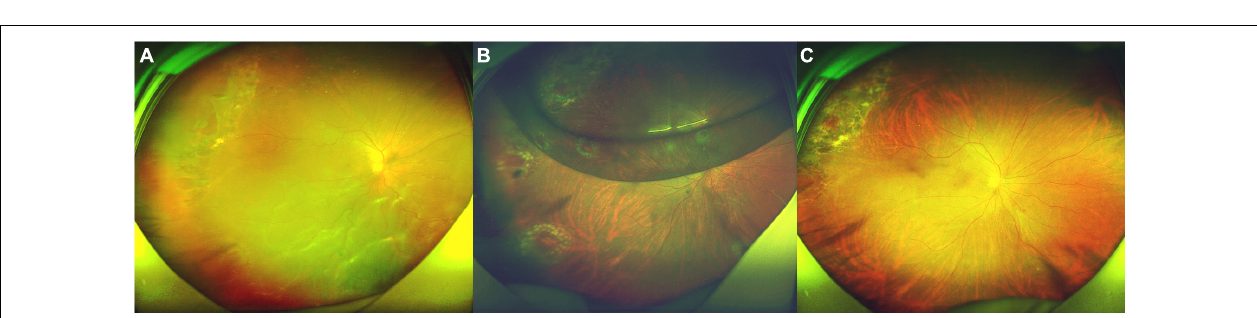
Frontiers in Medicine |